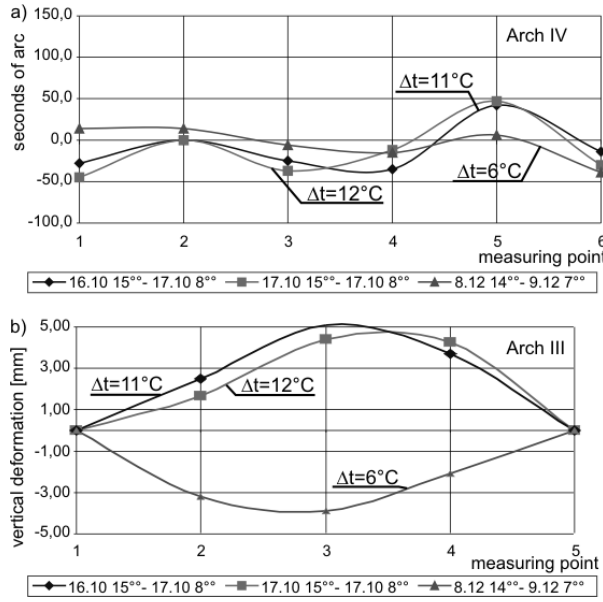
Fig 17. Transverse tilt of breast walls (a); vertical defor- mations of breast wall tops (b)